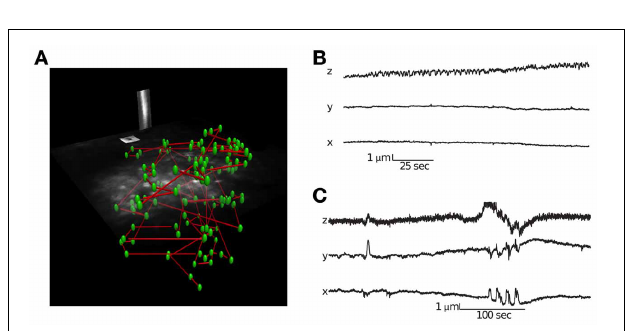
FIGURE 2 | Visualization of a scanning path and interleaved motion tracking planes. (A) The location of all cells is labeled green and the scanning path is labeled blue. Interleaved into this scanning path are points located in two orthogonal motion tracking planes placed over a vessel and neuroglia. Motion tracking is computed from these orthogonal image planes in 3D (see Methods for details). (B) Movement traces from a session with little lateral movement but axial drift. (C) Movement traces from a session with large abrupt